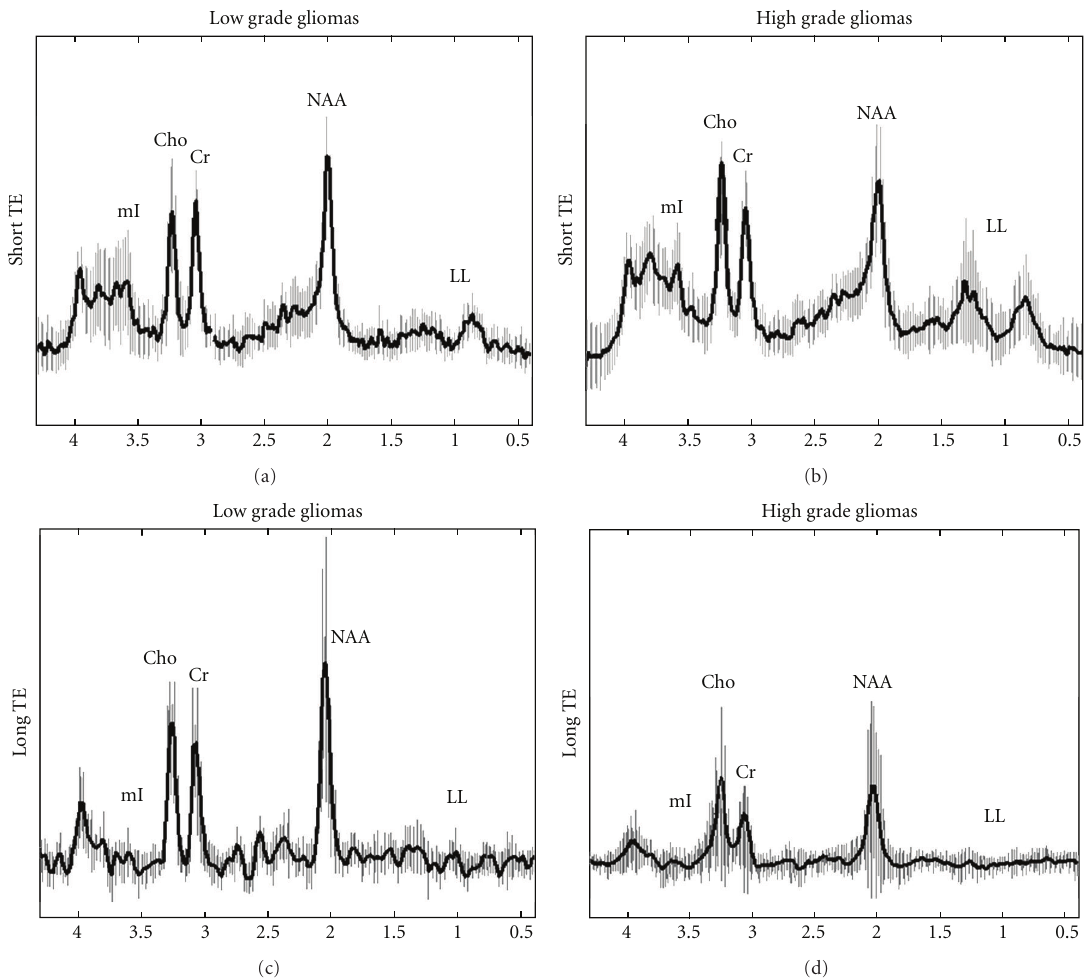
Figure 5: In vivo short TE ((a), (b)) and long TE ((c), (d)) mean spectra with their corresponding standard deviations (vertical lines) from the peritumoral area of low grade ((a), (c)) and high grade gliomas ((b),